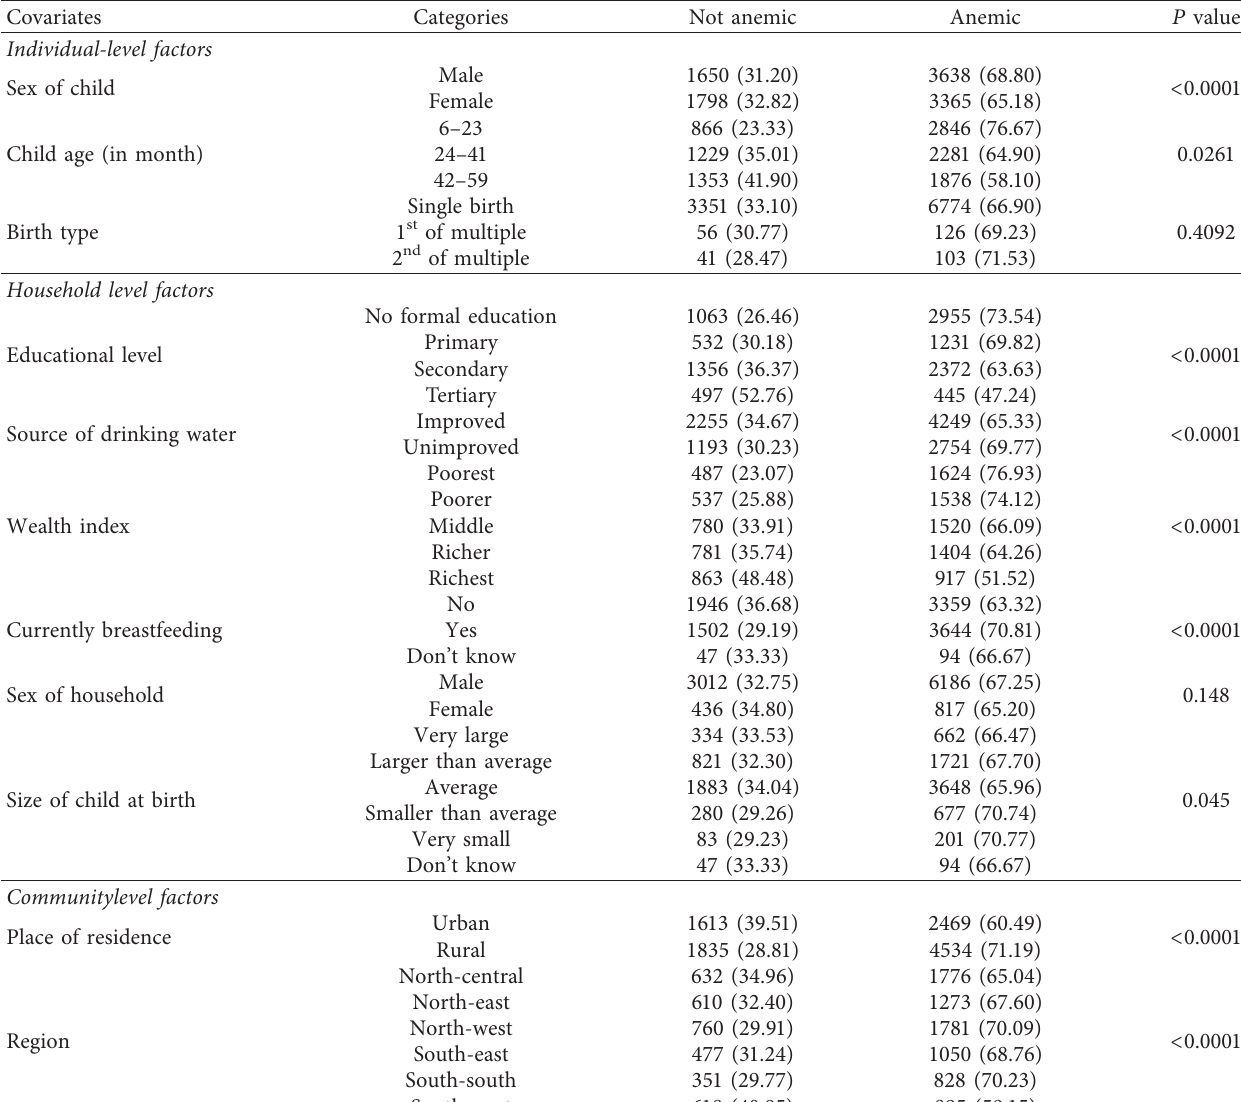
Table 2: Prevalence of anemia by various explanatory